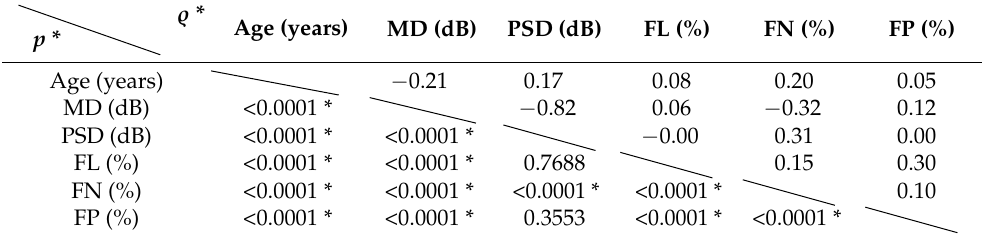
Table 2. Possible associations among